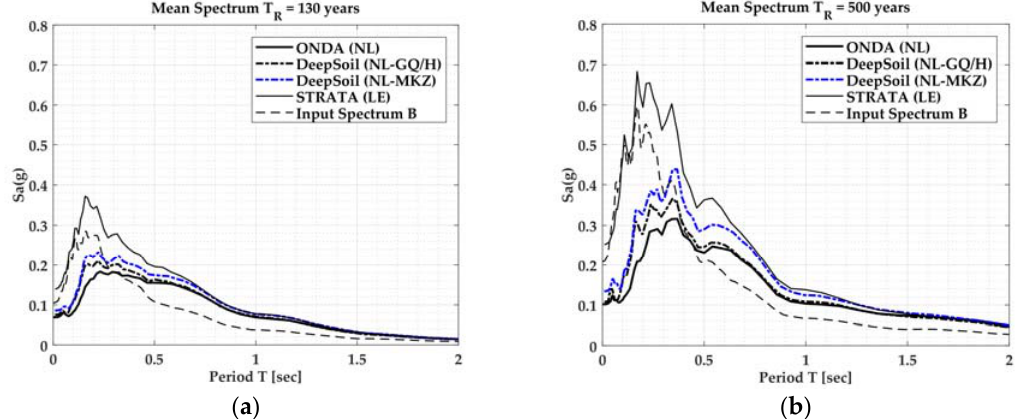
Figure 16. Comparison between results of different SRA analyses: ( a ) RP = 130 years; ( b ) RP = 500 years.